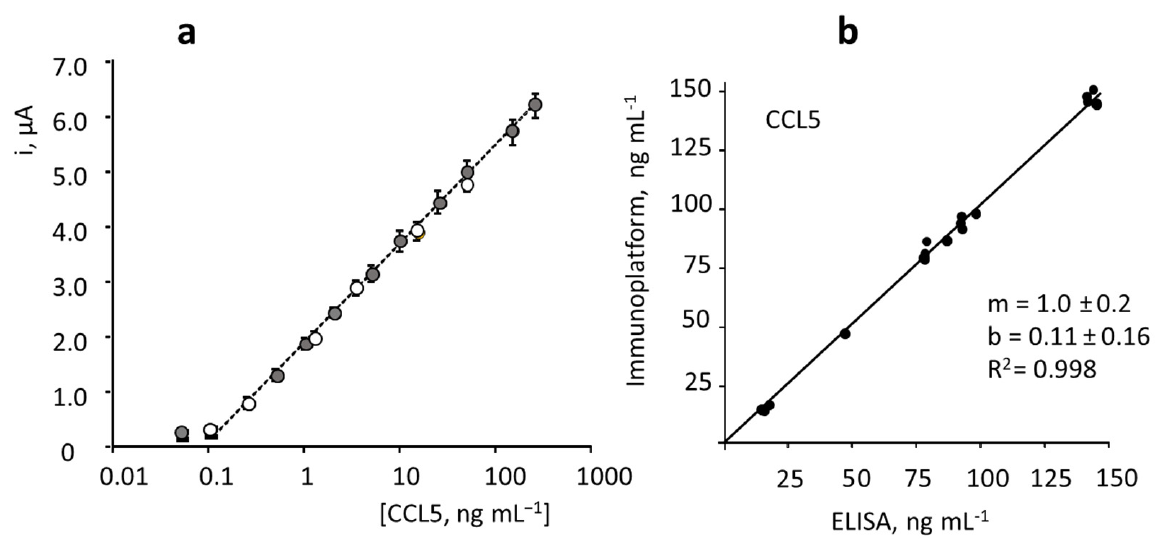
Figure 7. ( a ) Comparison of the calibration plots constructed with the HRP–IgG–anti–CCL5–CCL5– anti–CCL5–Biotin–Neu–MBs/SPCE immunoplatform for CCL5 standards in buffered solutions (white) and in CCL5-spiked100-fold diluted human serum (grey). Error bars estimated as triple standard deviation ( n = 3). ( b ) Correlation plot between the CCL5 concentrations obtained with the developed immunoplatform and the ELISA method in serum samples (replicates made for each sample are included in the plot).